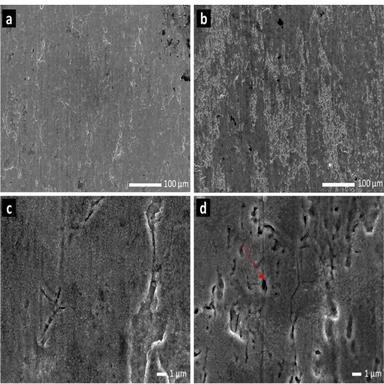
The SEM images of the surface before (a,c) and after (b,d) PCC with different magnifications. The red arrow shows the etching by PCC.